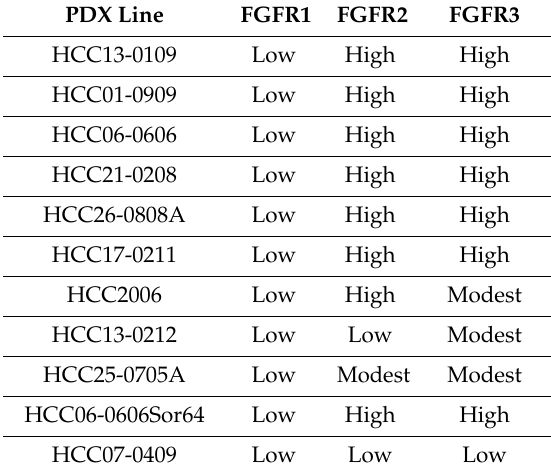
Table 1. FGFR1–3 expression in PDX lines used in this